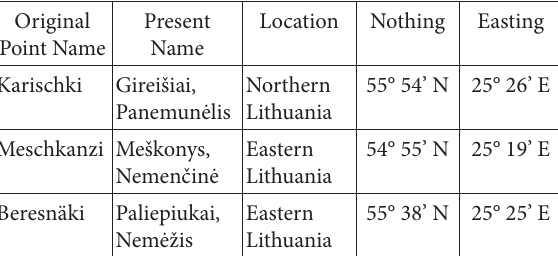
Fig. 2 . Monument of the Centre of Europe in Lithuania